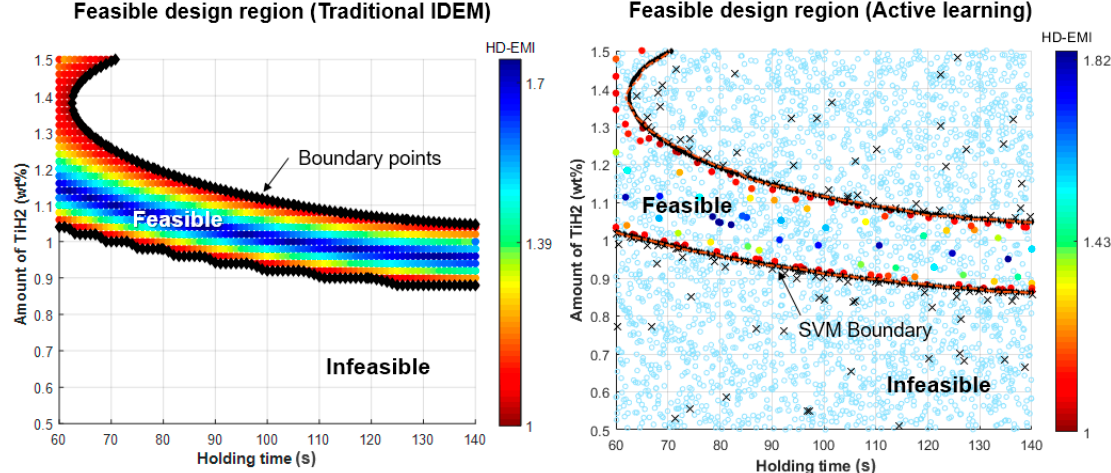
Figure 12. Feasible region obtained by traditional IDEM (left) and active learning (right) at processing level.